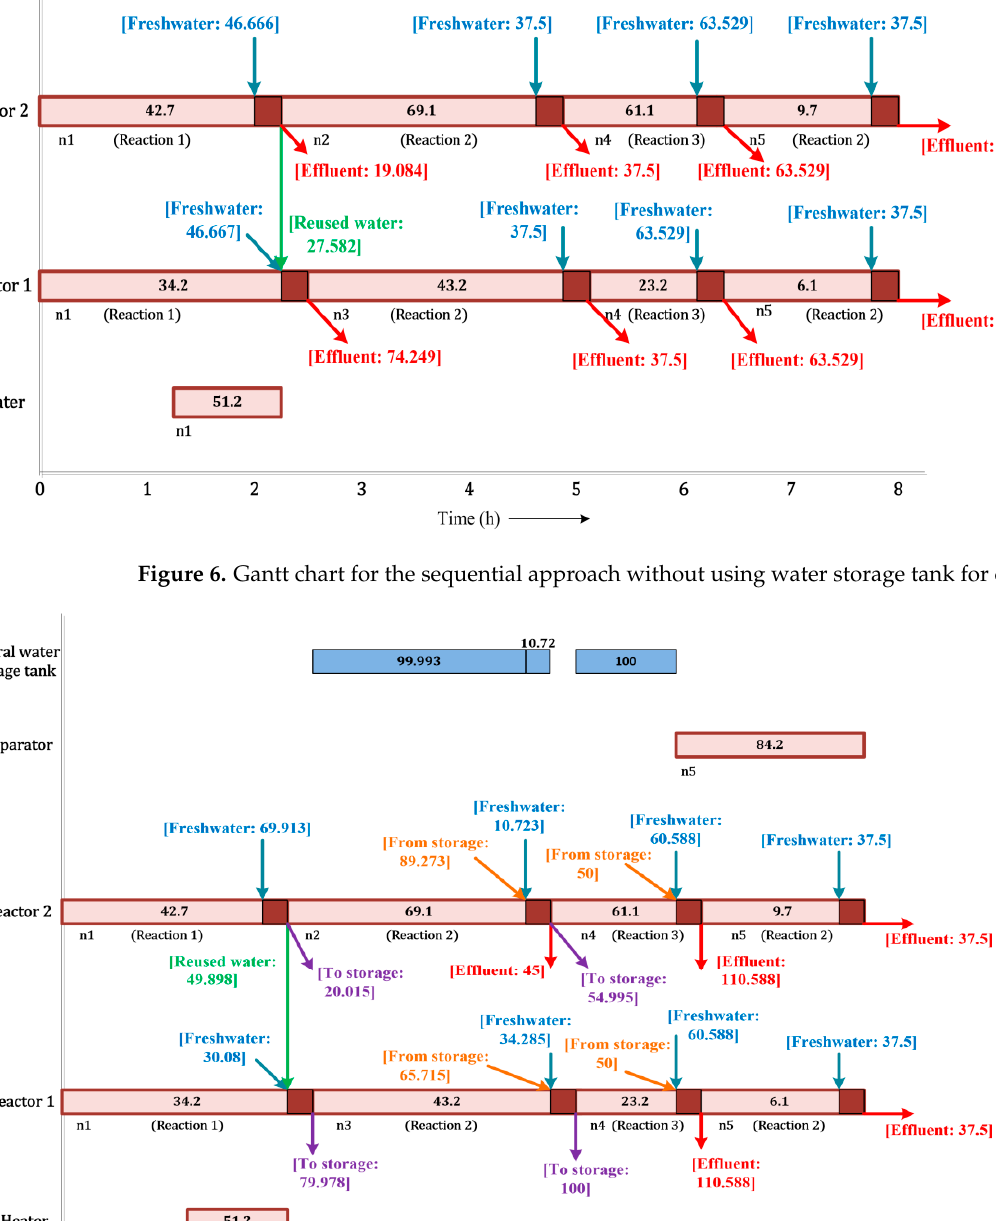
Figure 7. Gantt chart for the sequential approach using a water storage tank for case study 1.